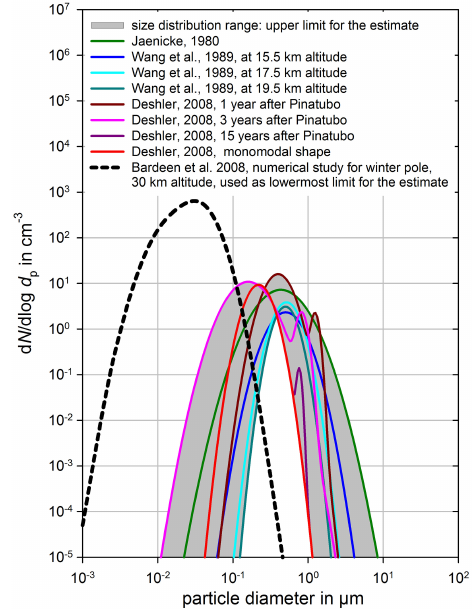
Figure 1. Model size distributions of stratospheric aerosol as pro- vided in parameterized form by different sources: Jaenicke (1980), Wang et al. (1989), and Deshler (2008), and one size distribution published in Bardeen et al. (2008), from numerical simulations of meteoritic material ablated in the mesosphere and subsided to 30km altitude. The gray shaded area denotes the range from maximum to minimum values of the size distributions that are used as the upper limit of the estimates described in Sect. 6. The size distribution re- sulting from numerical investigations serves as the lowermost limit of this